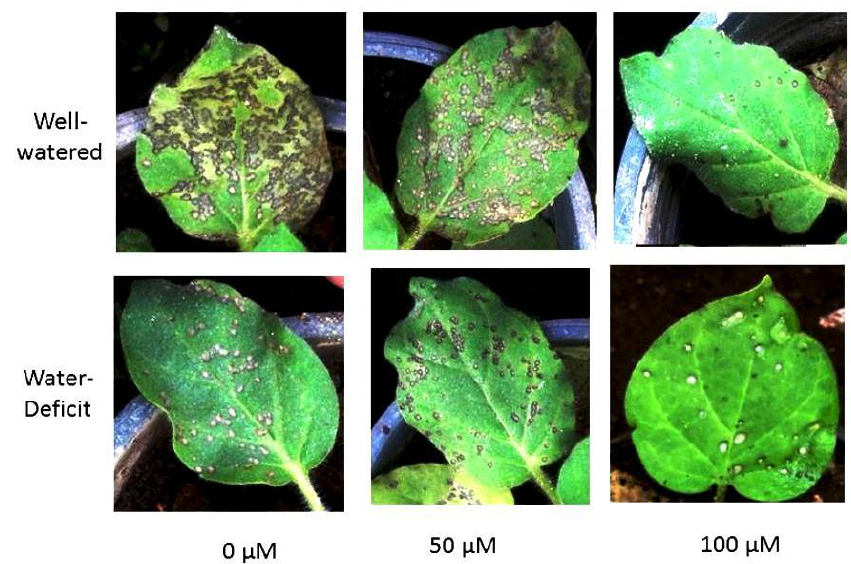
Figure 9. Biological estimation demonstrates the effect of SNP as a foliar application on the relative concentration of TMV isolated from naturally infected tomato plants grown in the field under two irrigation regimes in the second season. The higher number of local lesions on the viral plant detector ( Nicotiana glutinosa ) indicates a higher relative concentration of virus particles in the infected tomato plants.